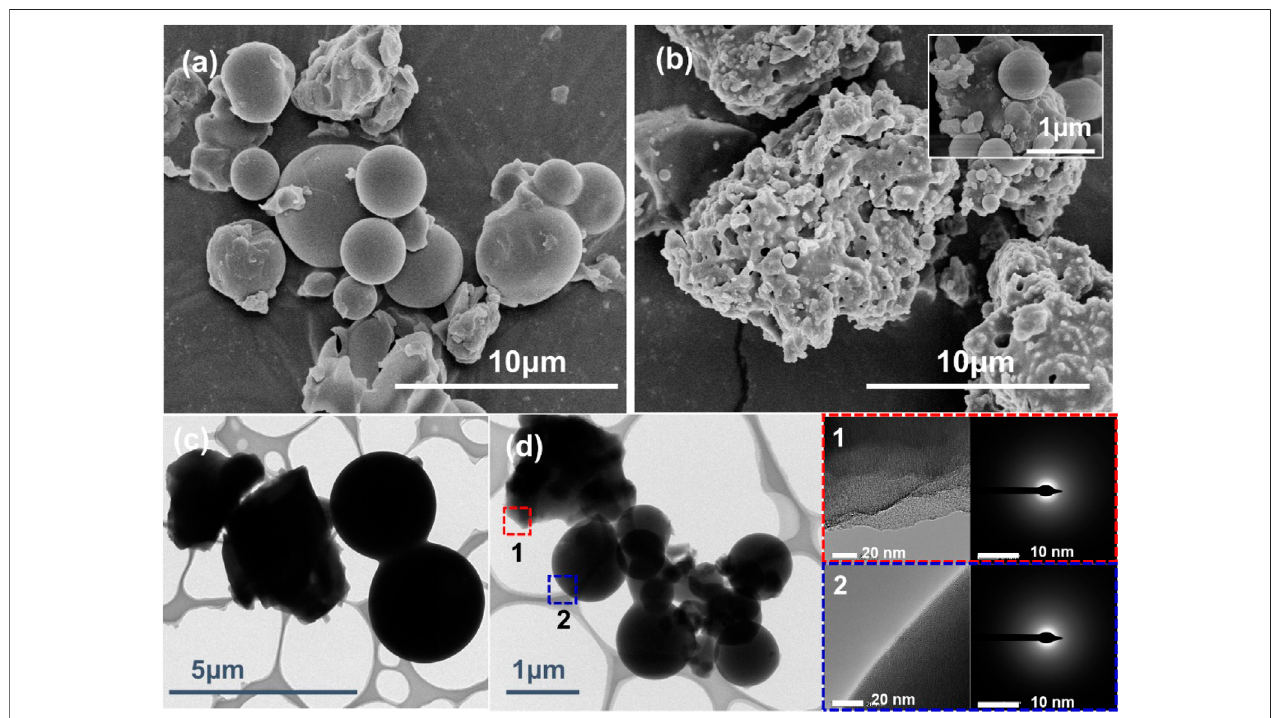
FIGURE 2 | SEM images of PIL (A) , PIL/TiO 2 (B) , and TEM of PIL (C) and PIL/TiO 2 with the electron diffraction pattern of selected parts (D) . Inset (B) is the SEM image of PIL/TiO